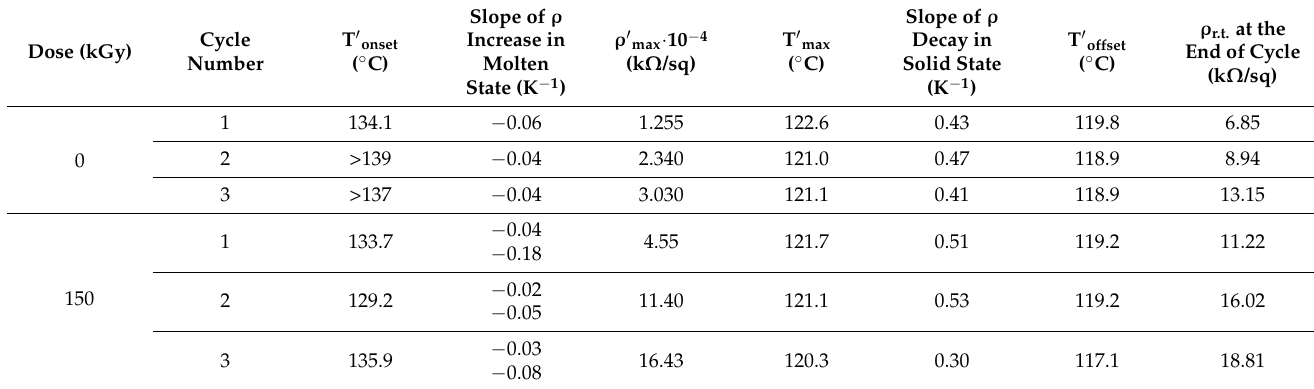
Table 5. Kinetic data of resistivity change upon the cooling of (CB + Gr)/(LLD + HD)